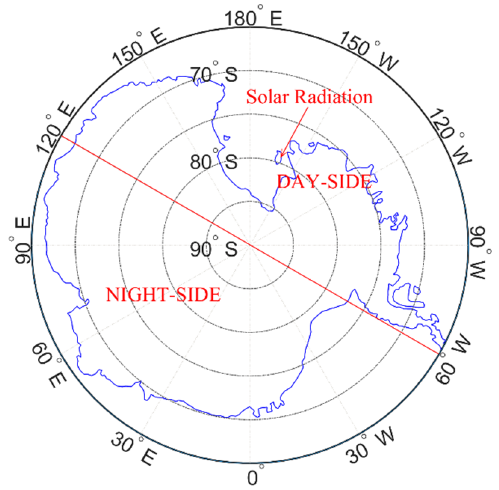
Figure 3. Division of latitudes in the illumination area and back-light area of the Antarctica at 02:00 UT during March and September.